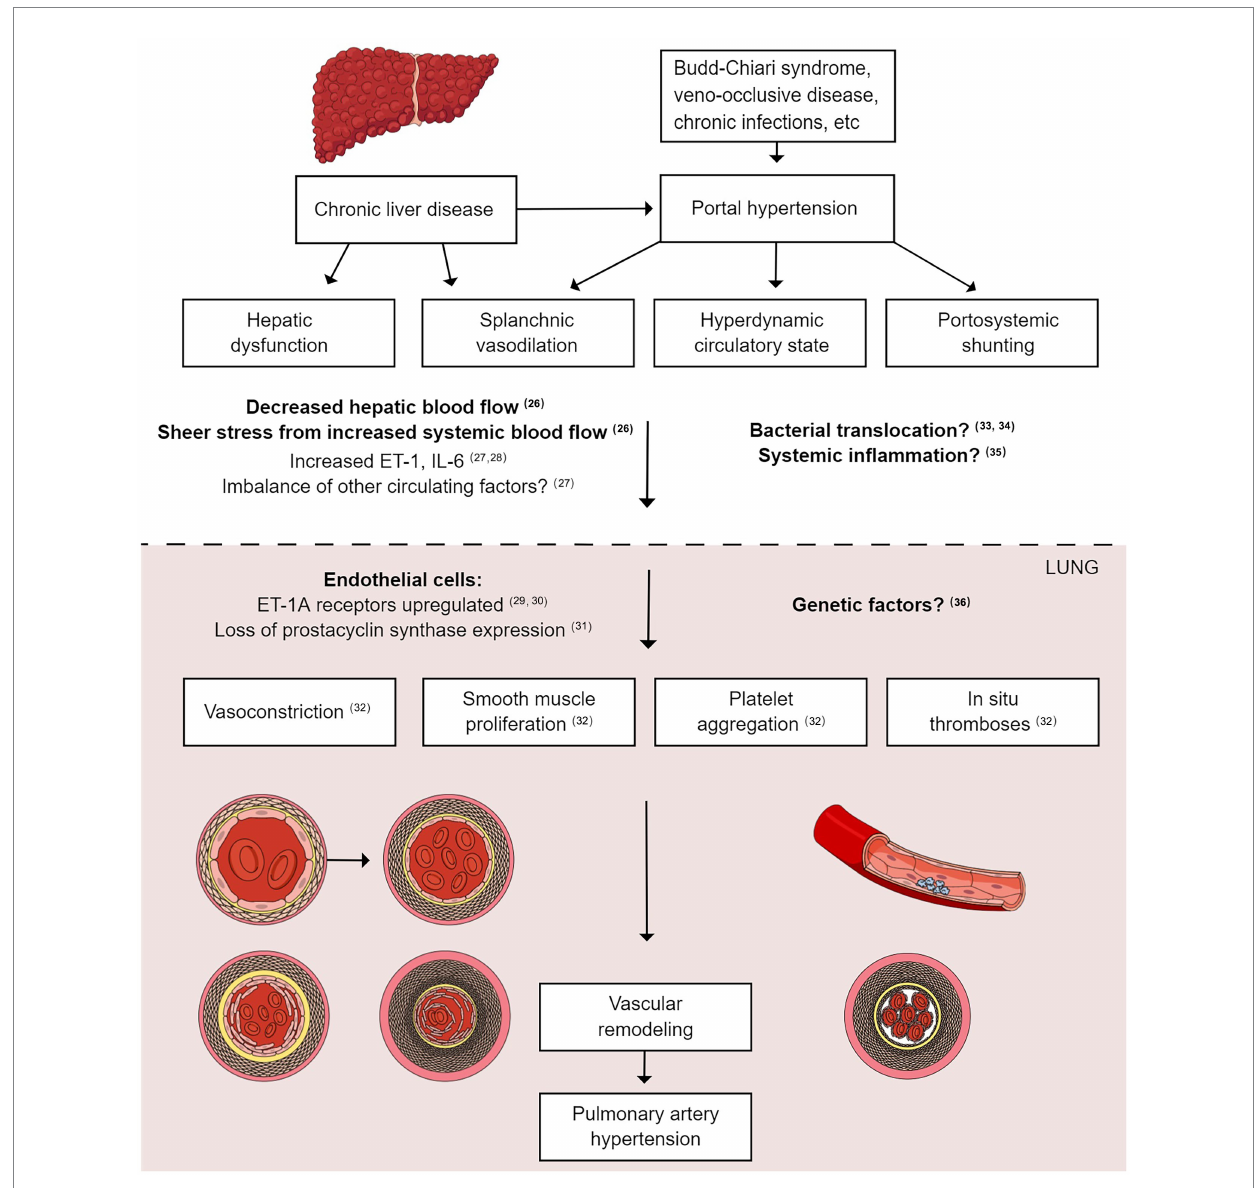
FIGURE 1 Pathophysiology of portopulmonary hypertension. Liver cirrhosis increases intrahepatic resistance and increases the portal pressure gradient, leading to portal hypertension. The reperfusion/dilation of existing vessels causes portosystemic collateralization. Vasoactive substances bypass the liver and evade hepatic metabolism due to portosystemic shunting, leading to a hyperdynamic state. Endothelin-1 and interleukin-6 are among the circulating substances that reach the pulmonary vasculature, leading to net vasoconstriction and an increase in PVR. Smooth muscle cell proliferation, platelet aggregation, and in situ thrombosis also occur, leading to vascular remodeling and PAH. PAH, pulmonary arterial hypertension; PVR, pulmonary vascular